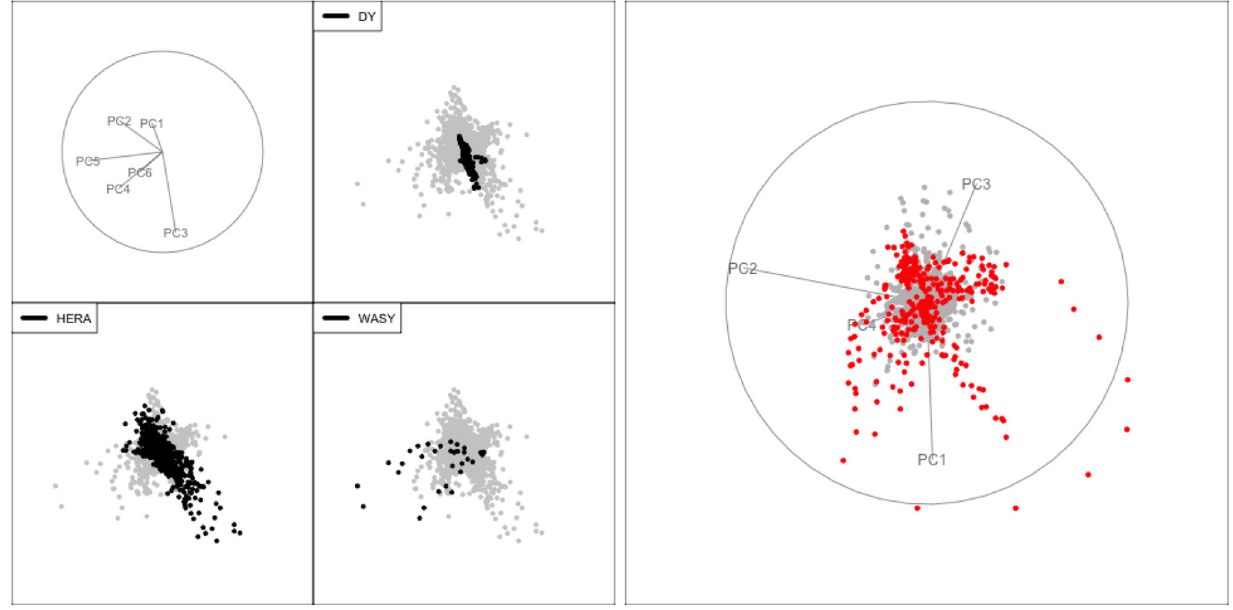
Fig. 9 Left: Comparison of groups with large reciprocated distance measures, where now the full dataset is shown below in gray. Right: Comparison in subspace found by performing PCA on DY data only, where DY data is shown in red and all other data points are shown below in gray. Again selected views from the grand tour results are